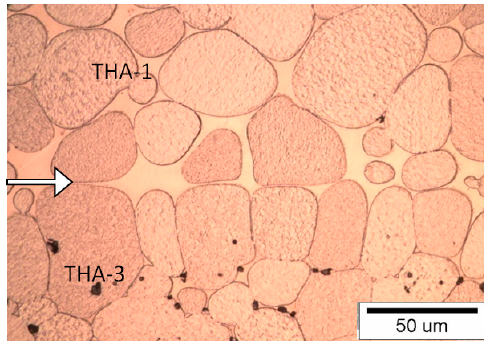
Figure 6. View of the microstructure of the THA-1 with THA-3 (THA-1 on the top) at a magnification 500× (the connection line (joint) is shown by the arrow).